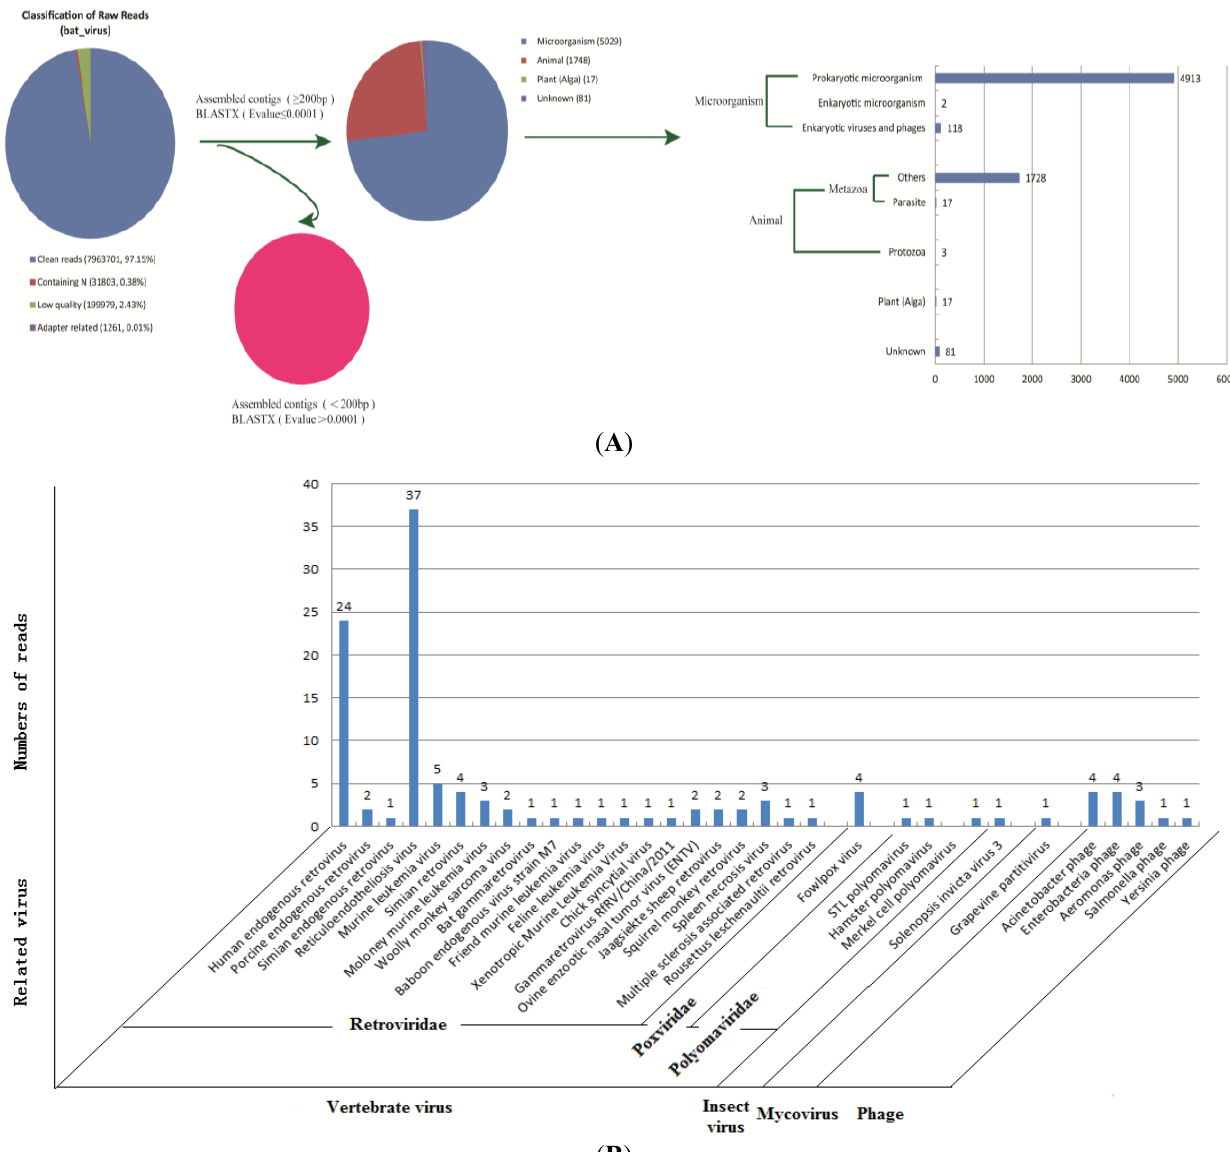
Figure 2. Schematic summary of the number of Illumina high-throughput sequencing reads. ( A ) Classification of raw reads, and contigs ( ≥ 200 bp) compared with Genbank using BLASTx searches (e-value < 0.0001); ( B ) Reads related to eukaryotic viruses and